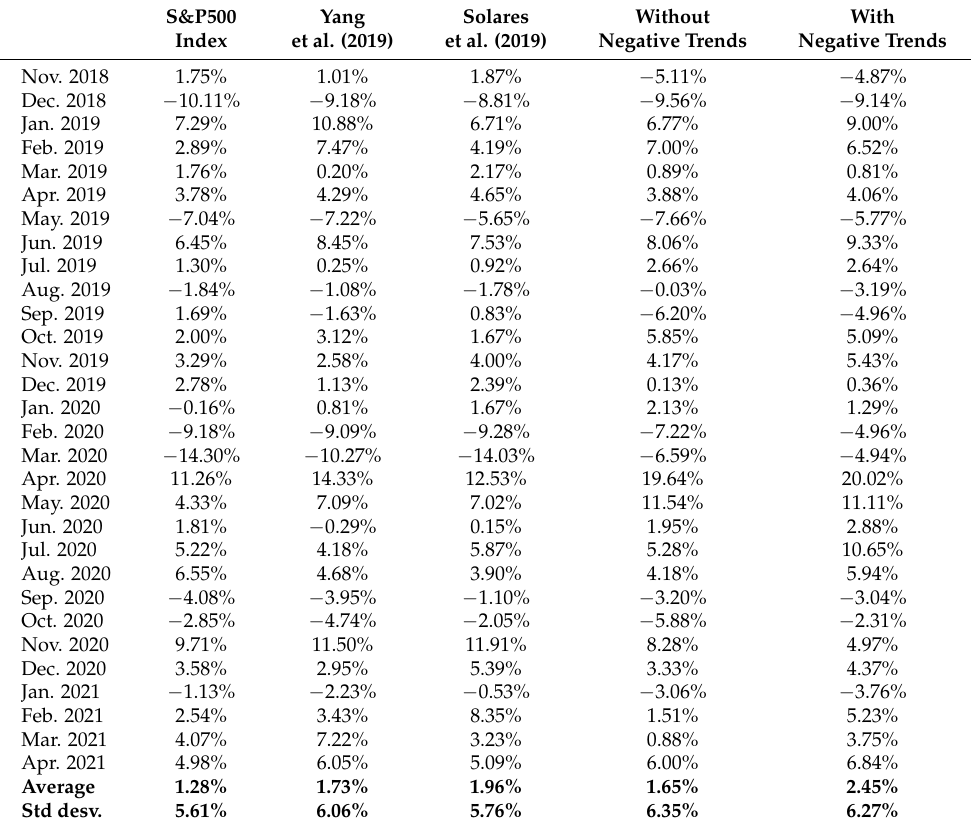
Table 1. Returns produced per period. In the case of the algorithms, the return is averaged in twenty